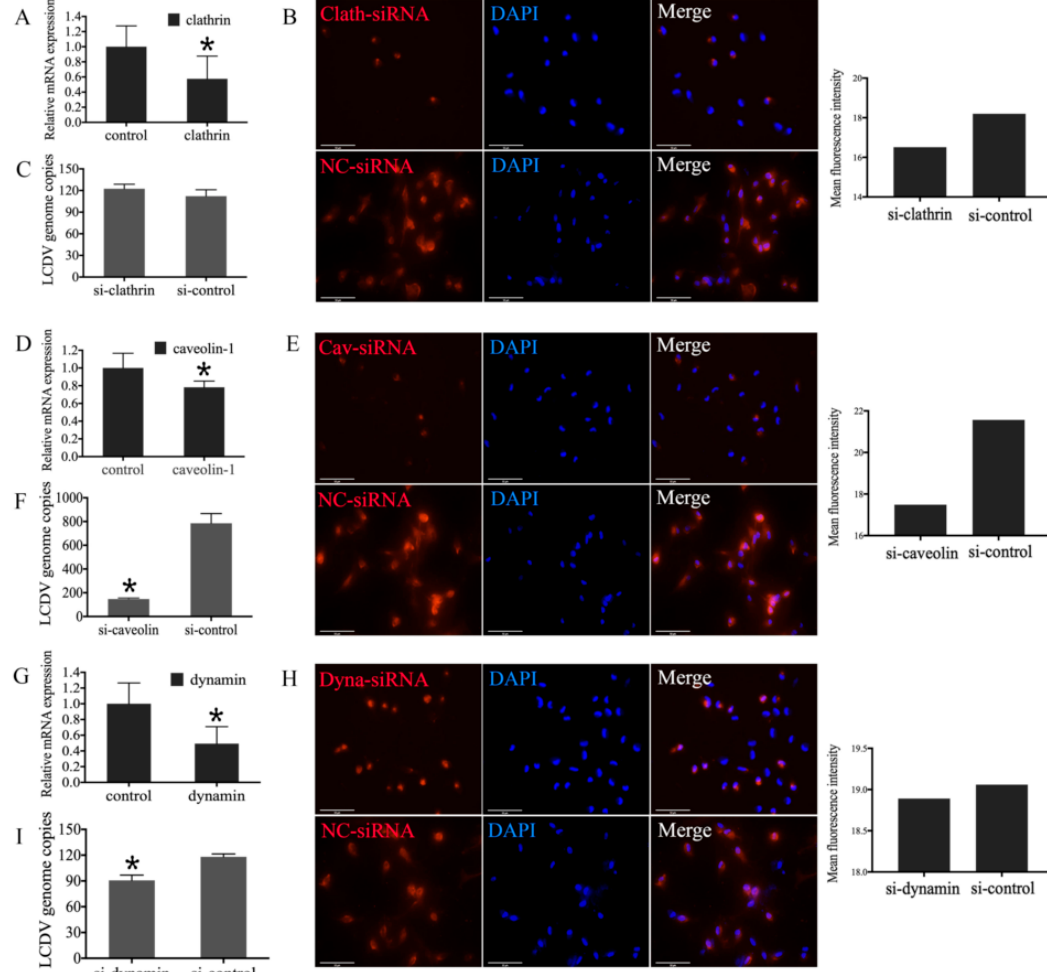
Figure 7. Effect of clathrin, caveolin-1, and dynamin knockdown on the LCDV infection of FG cells. RNA interference sequences were transfected into FG cells and gene expression of clathrin ( A ), caveolin-1 ( D ), and dynamin ( G ) was detected by qPCR; protein expression of clathrin ( B ), caveolin-1 ( E ), and dynamin ( H ) was detected by IFA, bars = 50 μ m, the mean fluorescence intensity of all cells in the field was measured using ImageJ software. RNA interference sequences were transfected into FG cells prior to infection with LCDV, and virus copy numbers in clathrin ( C ), caveolin-1 ( F ), and dynamin ( I ) knockdown FG cells were detected by qPCR. Error bars represent SD ( n = 3). Asterisks denote significant differences compared with negative controls ( p < 0.05, one-way ANOVA).